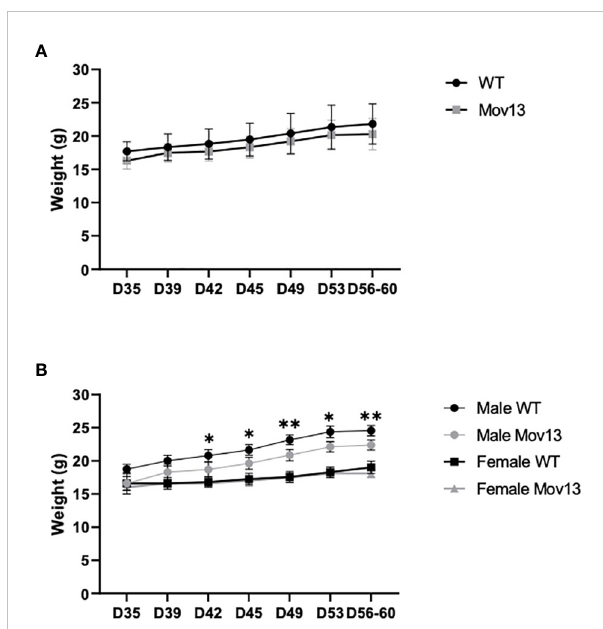
FIGURE 1 Weight of four-week-old till eight-week-old mice. (A) The weight of four-week-old Mov13 and WT littermates at different time points during four weeks. The age of the mice is presented on the x-axis in days. (B) Weight of four-week-old Mov13 and WT littermates divided in males and females during four weeks. Values of standard deviations (SD) are shown for each group: WT (n=10, 50%male) and Mov13 (n=10, 50%male). Statistical signi fi cance is indicated on the graphs (P-values ≤ 0.05 (*), ≤ 0.01